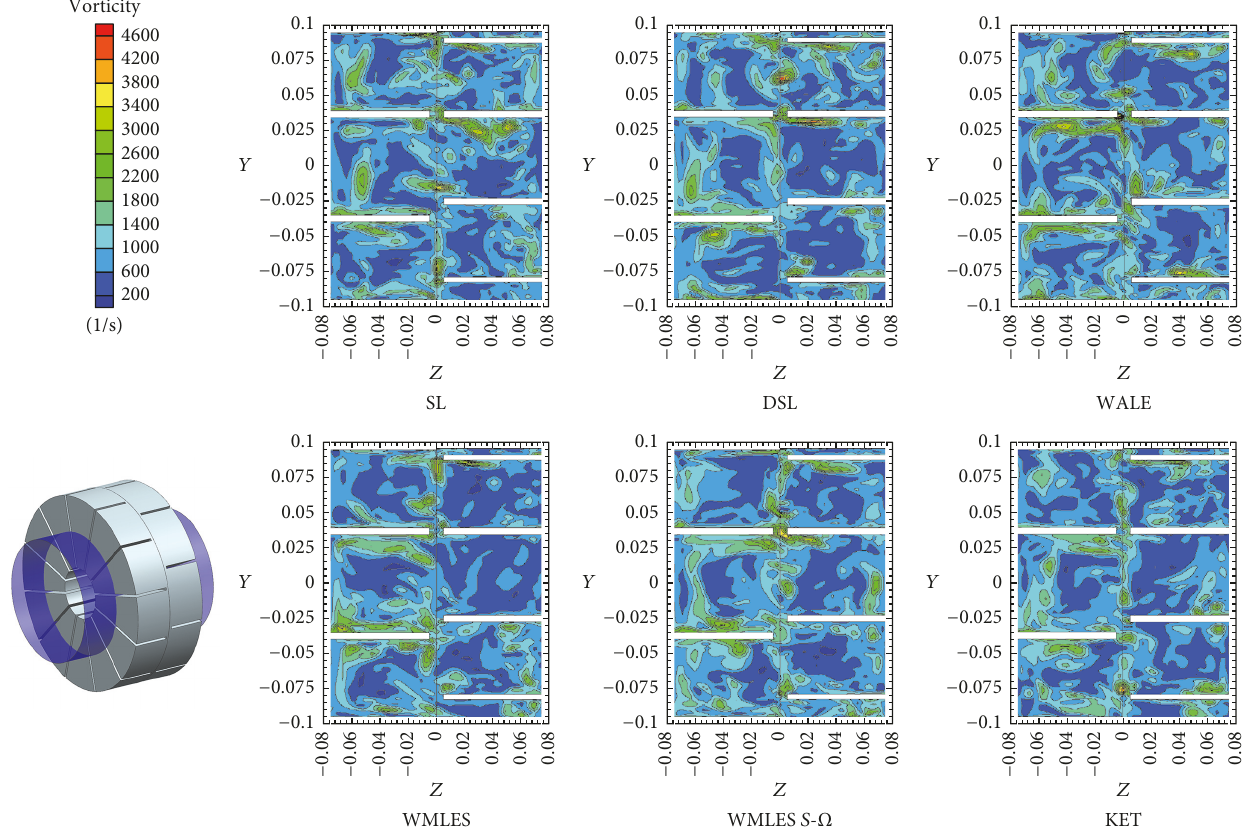
Figure 3: Vorticity distribution for different subgrid models.